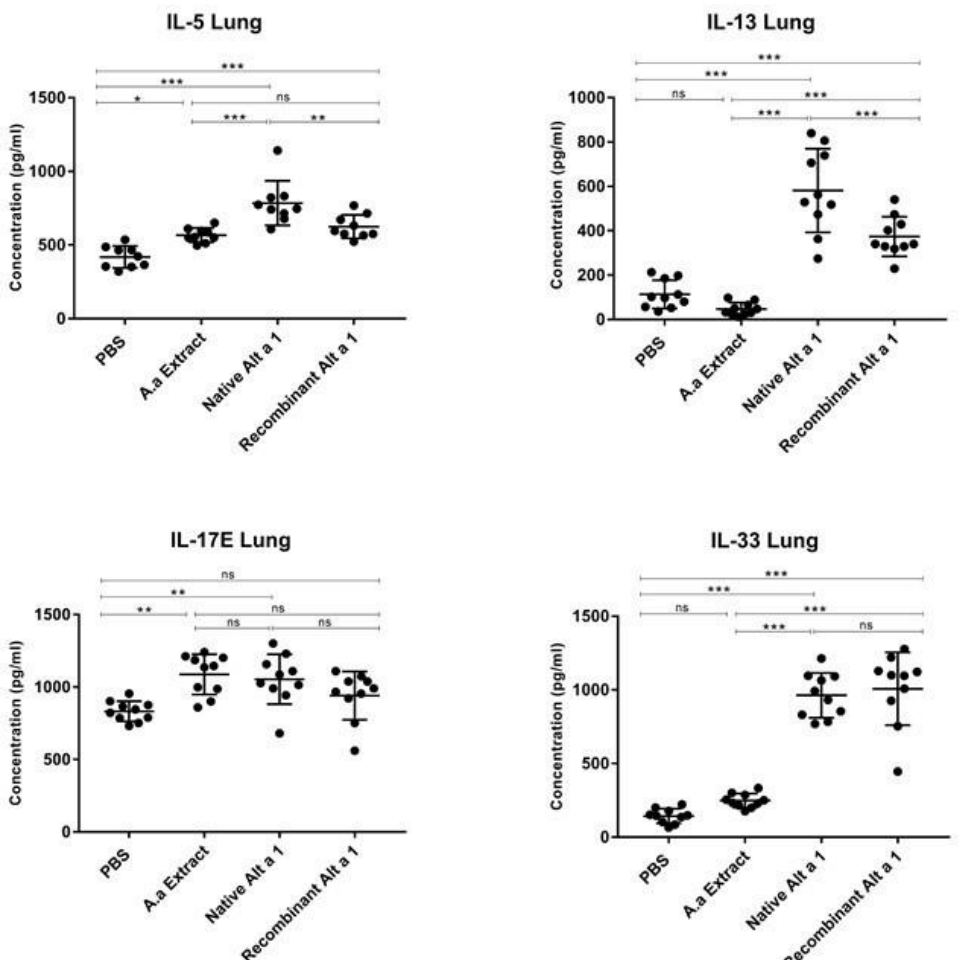
Figure 3. Quantification of IL-5, IL-13, IL-17E and IL-33 cytokines in lung homogenate in the groups of mice instilled with PBS; A.alternata Extract; native Alt a 1 (nAlt a 1) or with recombinant Alt a 1 (rAlt a 1). Lines represent the mean and bars the SEM. *, p < 0.05 **, p < 0.01; ***, p < 0.001; ns, no statistically significant differences ( p > 0.05).